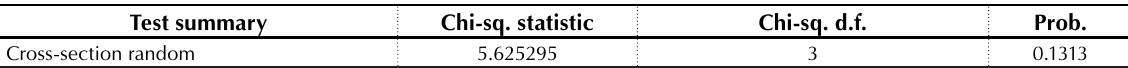
Source: Results of panel data regression output.